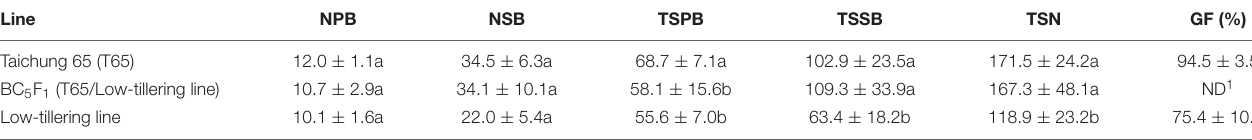
TABLE 3 | Panicle structure of “Taichung 65” (T65), BC 5 F 1 (T65/low-tillering line), and low-tillering